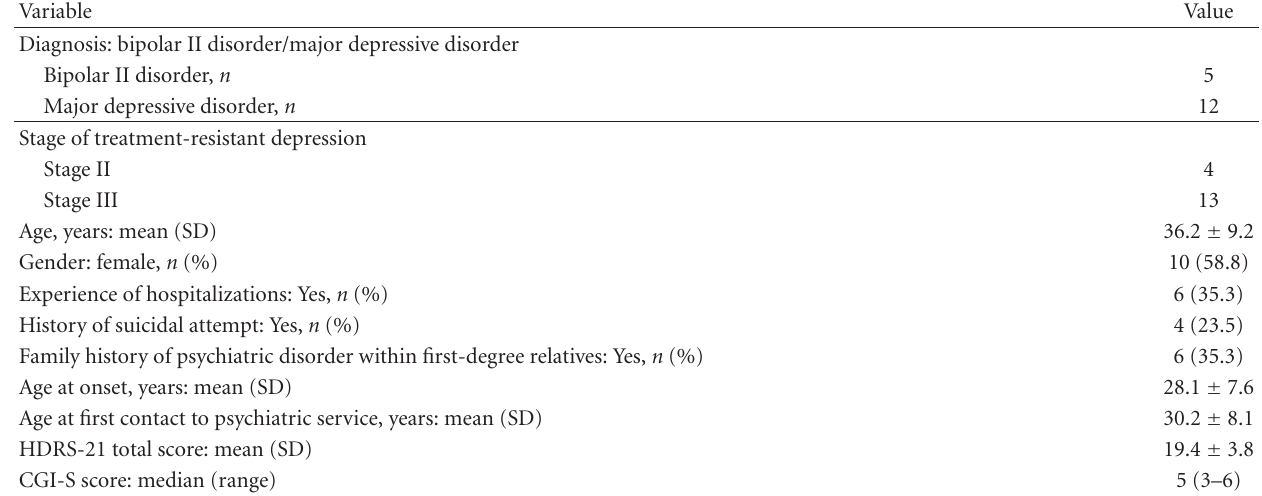
Table 1: Demographic characteristics and clinical variables at baseline.